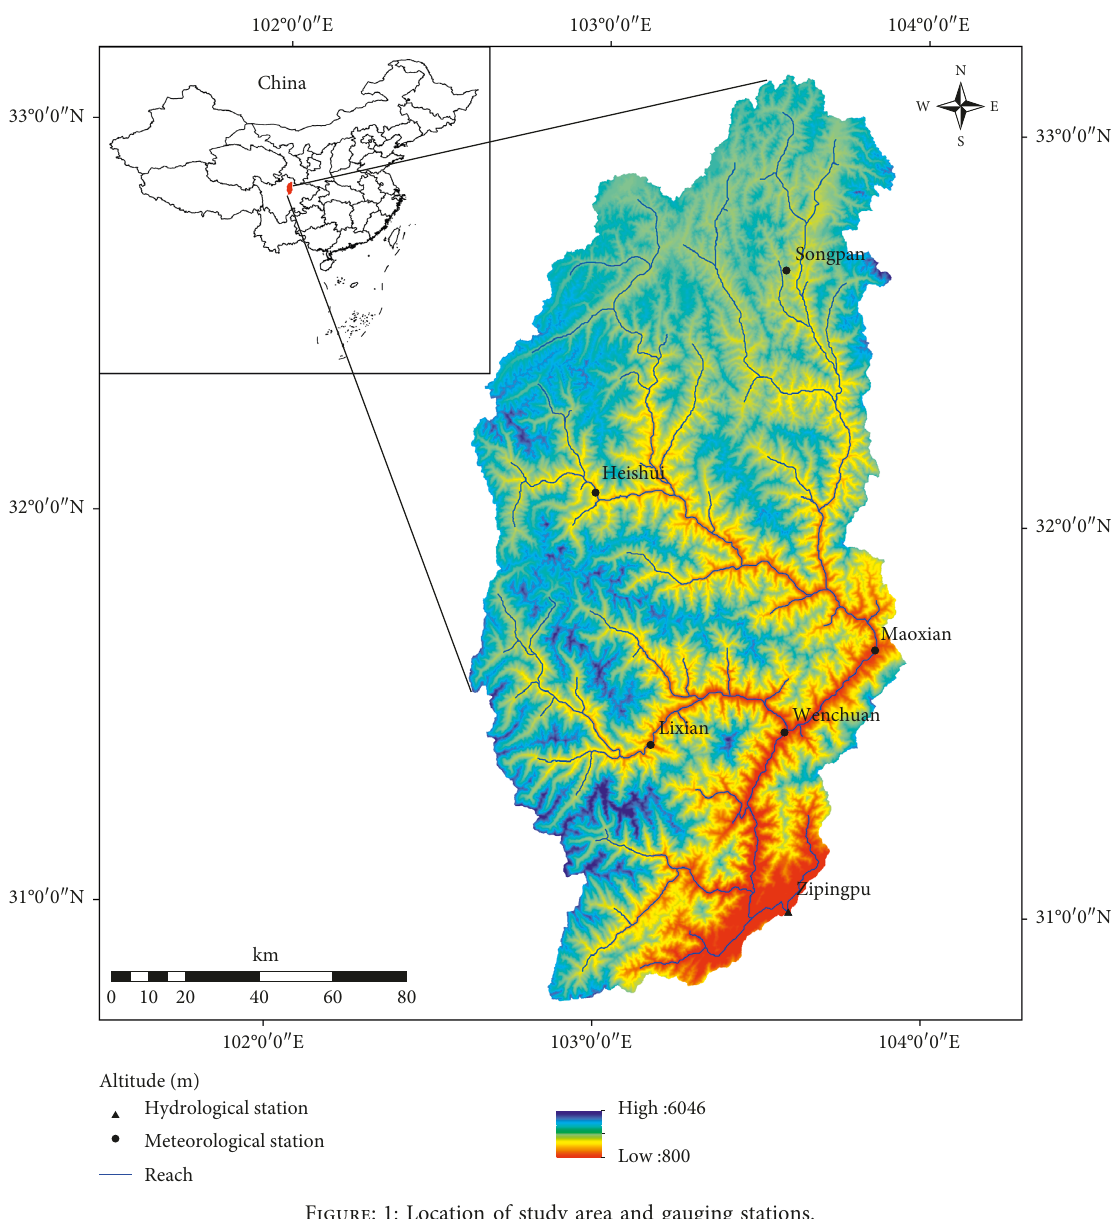
Figure: 1: Location of study area and gauging stations.